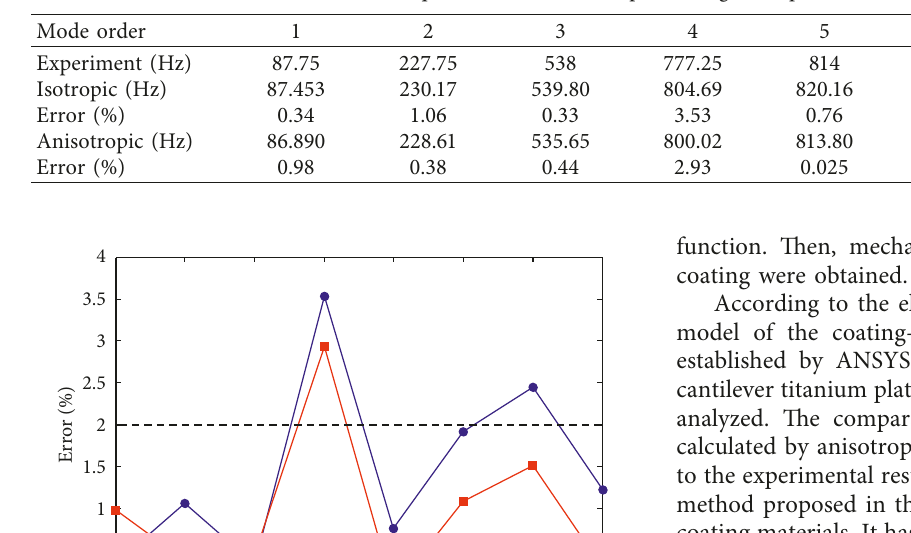
Table 4: Natural frequencies of the coated plate using isotropic and anisotropic parameters.